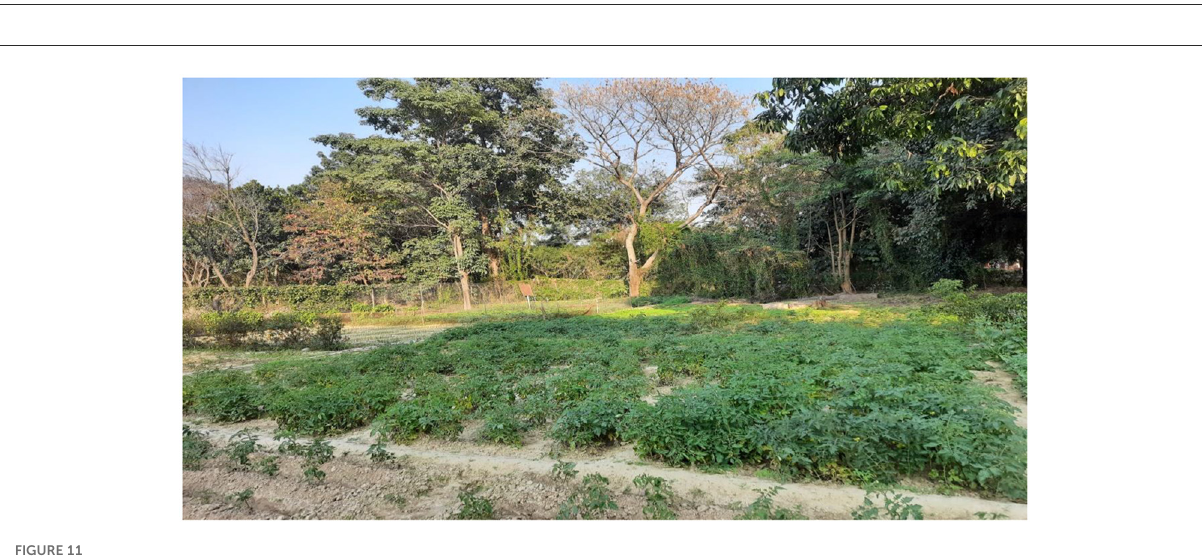
showed that the use of the synthesized Ag NPs against A. solani , the organism that causes early blight on tomatoes, significantly reduced